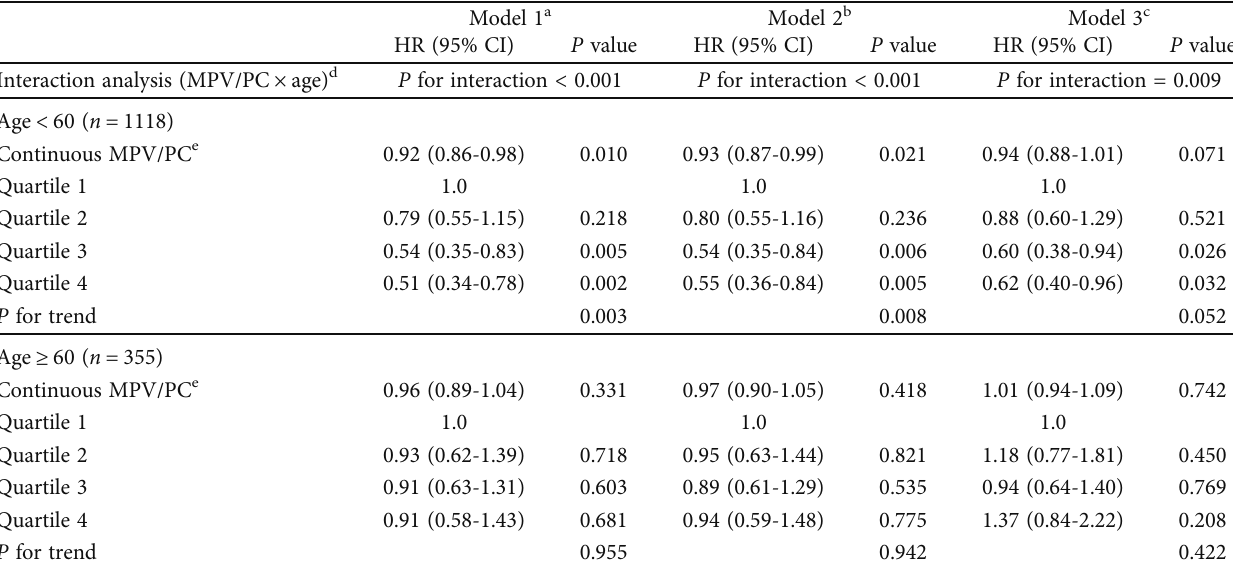
Table 4: The association of MPV/PC with all-cause mortality strati fi ed by age in PD